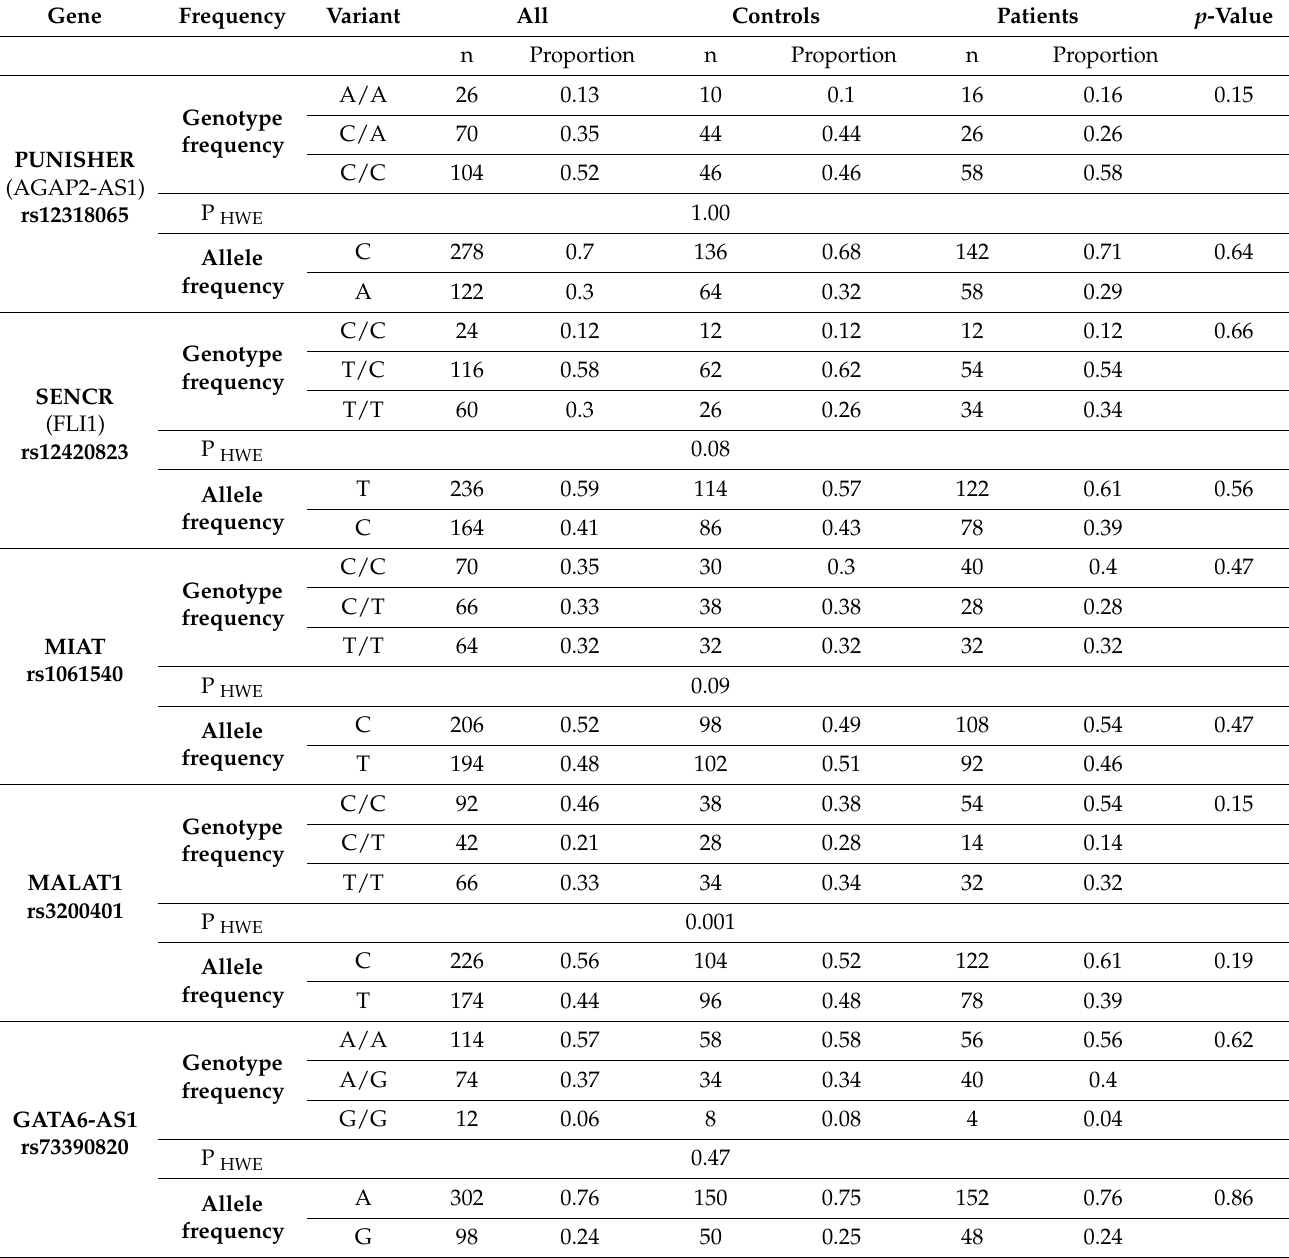
Table 2. Genotype and allele frequencies of the study lncRNA